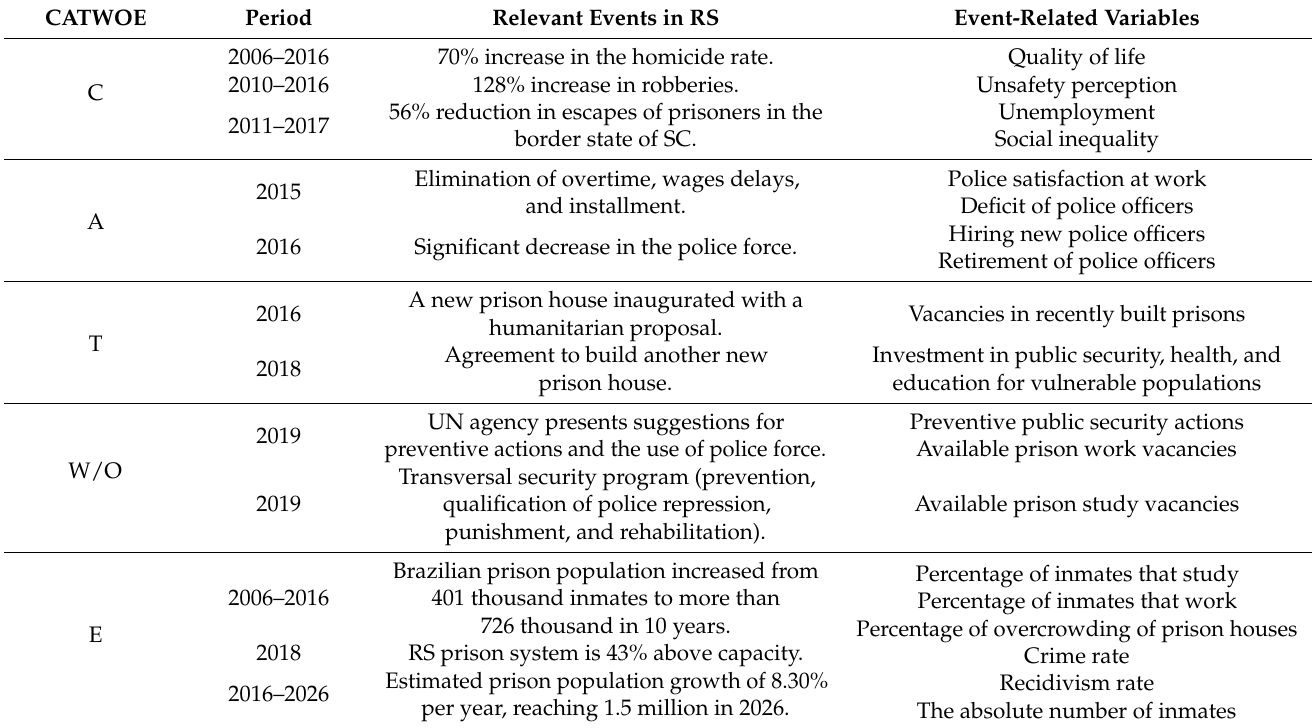
Table 1. Systemic events and variables.